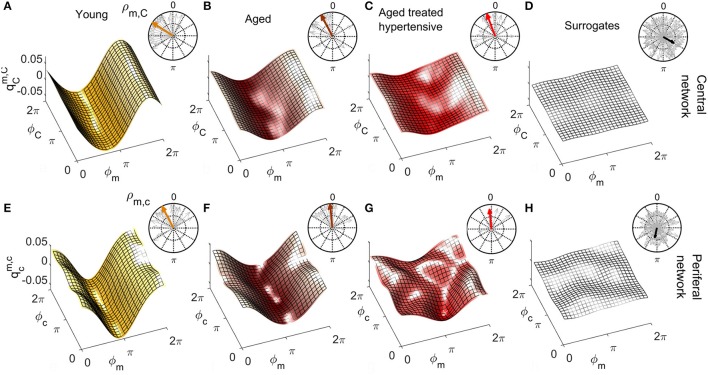
As in Figure 6 except that (A–C) represent the coupling functions qCm,C between the phase of myogenic ϕm and cardiac ϕC oscillations in the central network and (E–G) show qcm,c between the phases of myogenic ϕm and cardiac ϕc oscillations in the peripheral network. Plots (D,H) are from the corresponding surrogates. Again, the forms lose amplitude with aging in the central network, and with hypertension, resemble the variability of surrogates in the peripheral network.